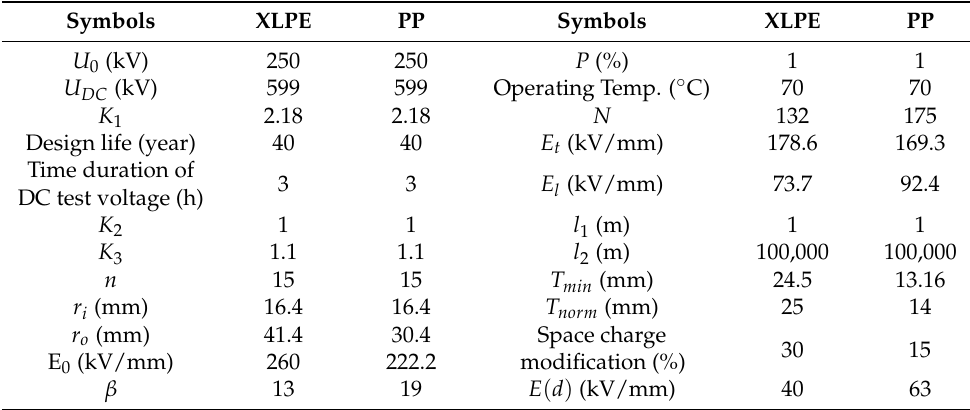
Table 1. Insulation design parameters for ± 250 kV HVDC